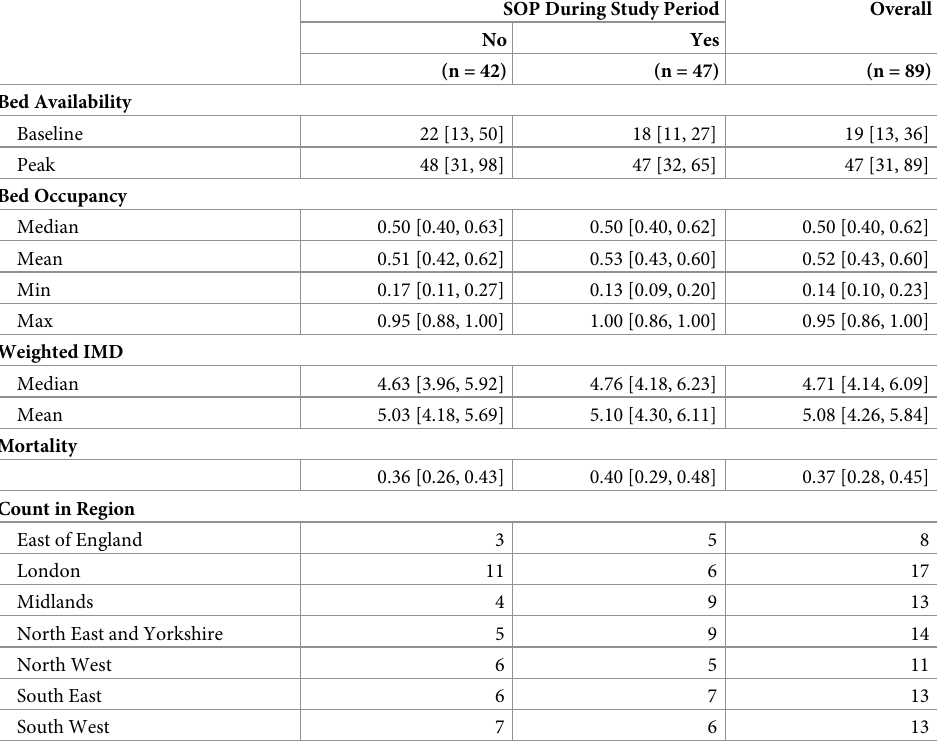
Table 2. Characteristics of trusts stratified by whether they reported a serious operational problem during the study period.